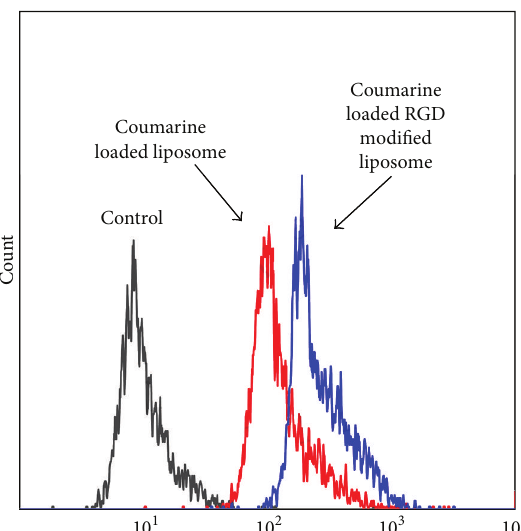
Figure 9: Flow cytometry profiles showed different cellular uptake of coumarin loaded liposomes with or without Chol-PEG-Chol by HUVEC cells (containing 40 ng/mL coumarin at 37 ∘ C for 1 hour).